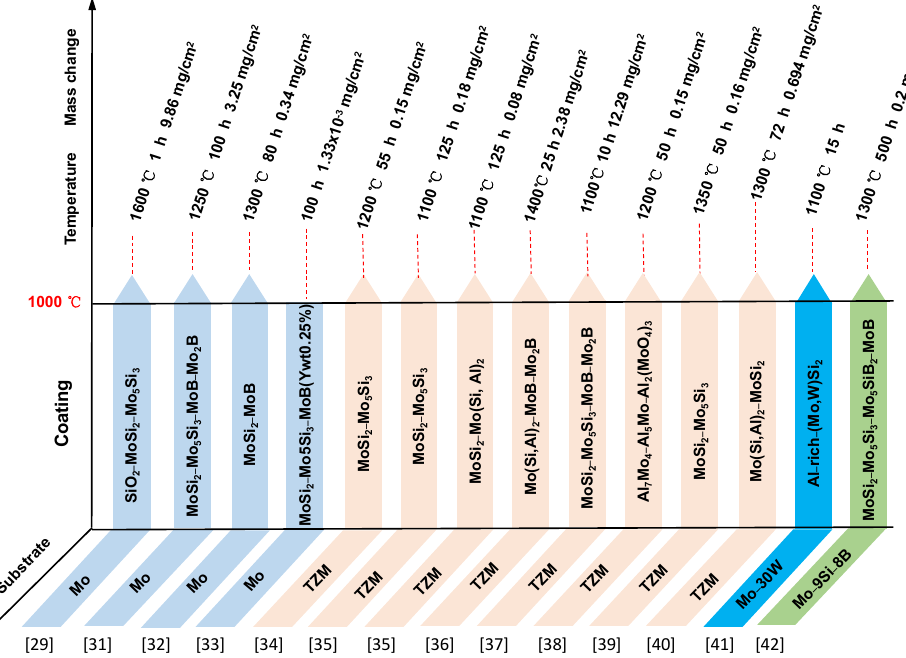
Figure 7. Overview of the composition and oxidation characteristics of HAPC coatings on the surface of Mo and its alloys.